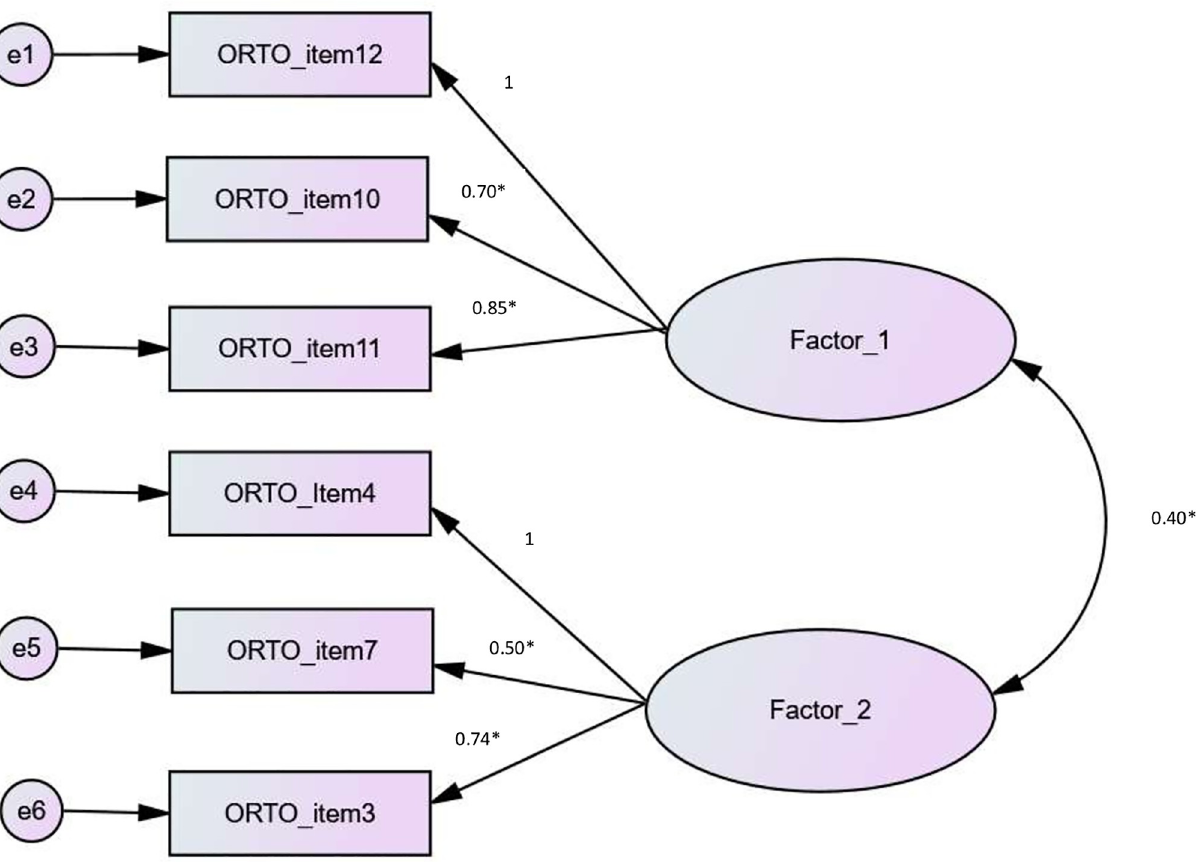
Fig 1. Standardized factor loadings of one factor model of the Arabic version of the ORTO-R.